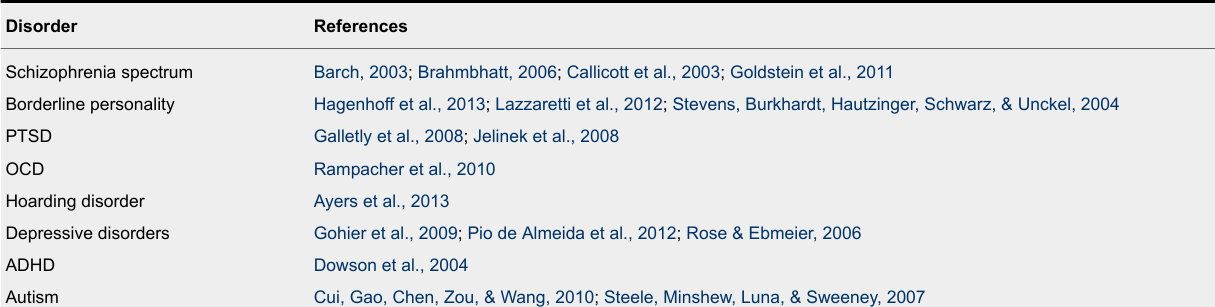
Mental Diagnoses Associated With Impaired WM Performance